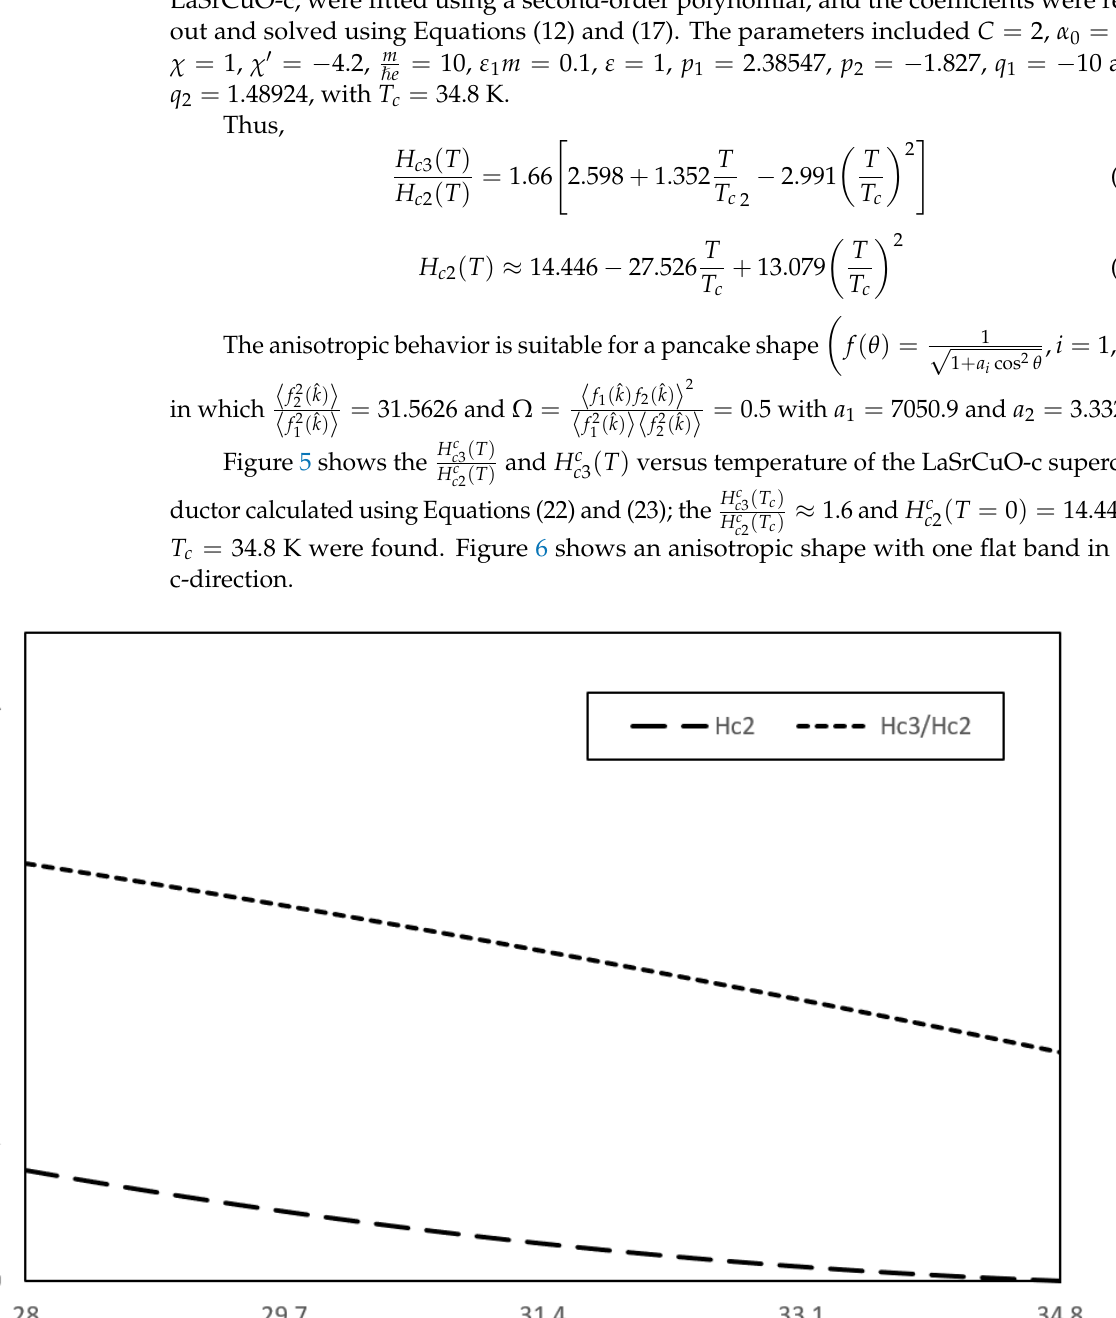
1.85 Sr 0.15 CuO 4 -c